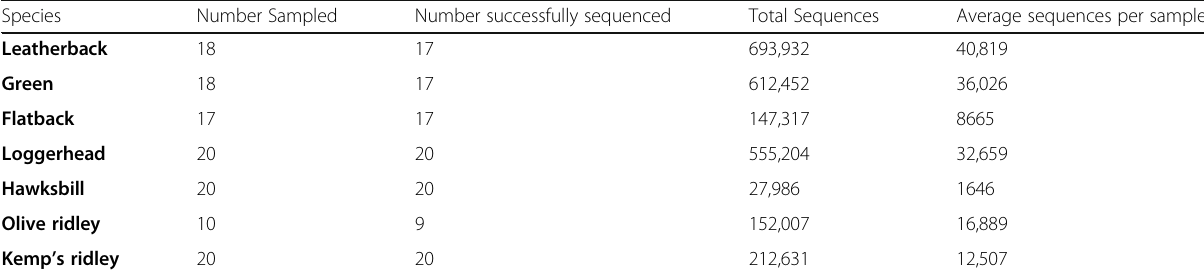
Table 1 Summary of sequencing results